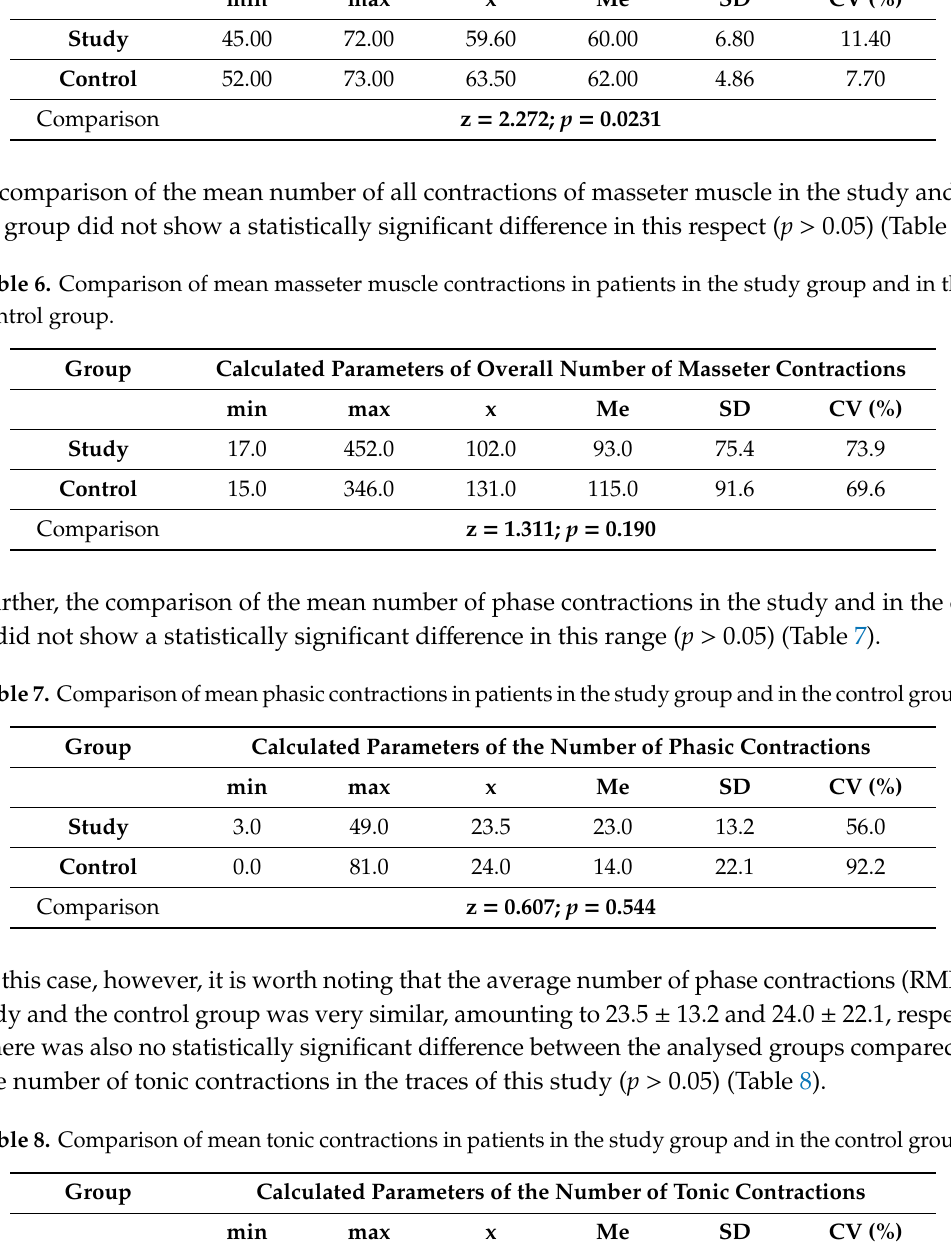
Table 5. Comparison of mean heart rate in patients in the study group and in the control group. Group